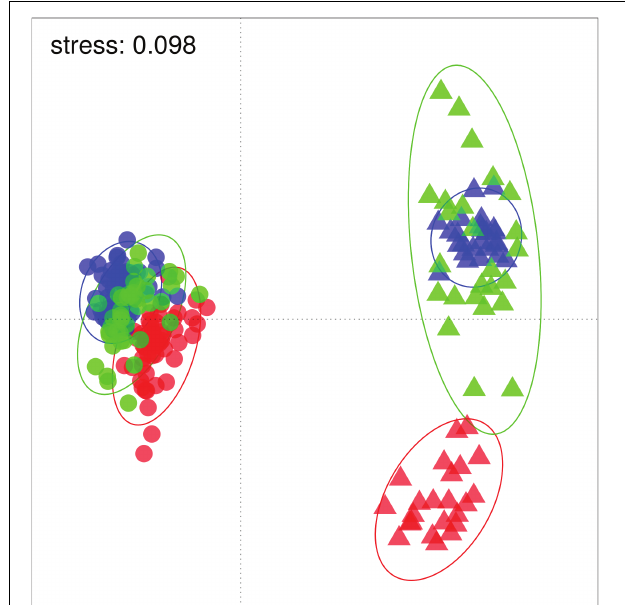
FIGURE 2 | Non-metric multidimensional scaling (NMDS) plot based on Bray-Curtis dissimilarities of square-root transformed standardized catch. Historical and re-survey samples are indicated by circles and triangles respectively, while sites are separated by color (Cape Infanta blue, Mossel Bay green, Bird Island red). Bounding ellipses represent 95% probability contours estimated for each period-site level.